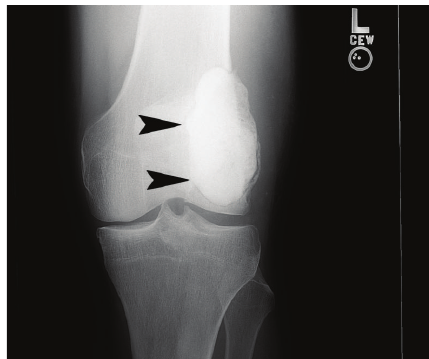
Figure 8: Frontal left knee radiograph (August 2007) demonstrates postsurgical curettage and packing with radiopaque polymethyl- methacrylate (PMMA) of a well-defined, solitary, mixed lytic, and sclerotic lesion with a narrow zone of transition (arrows), located within the distal femoral metaphysis.